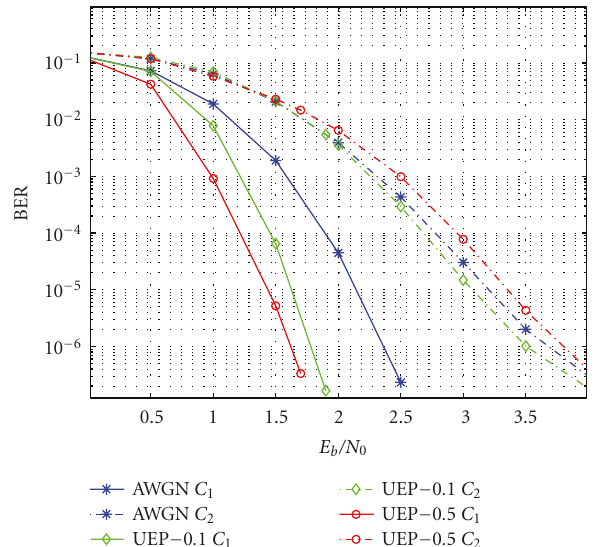
Figure 3: Bit error rate performance of di ff erent classes versus E b /N 0 after 7 decoding iterations. We have improved performance for class 1 and 2 for the LDPC code optimized with UEP constraints N = 4096.